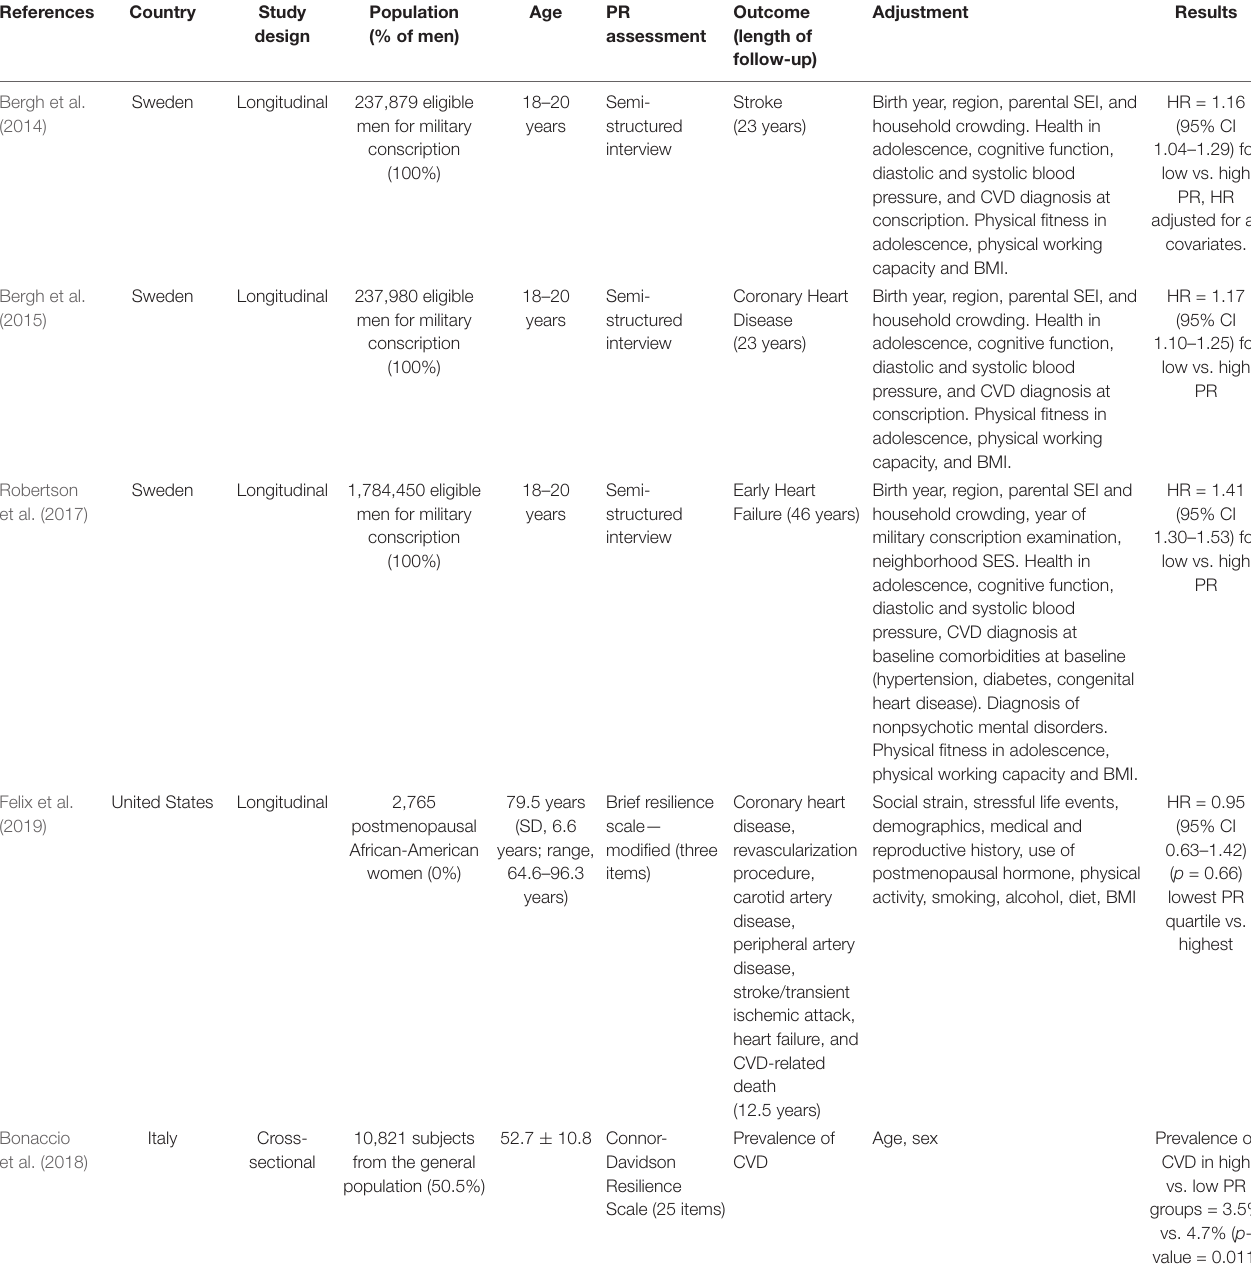
TABLE 1 | Psychological resilience (PR) and cardiovascular disease (CVD)